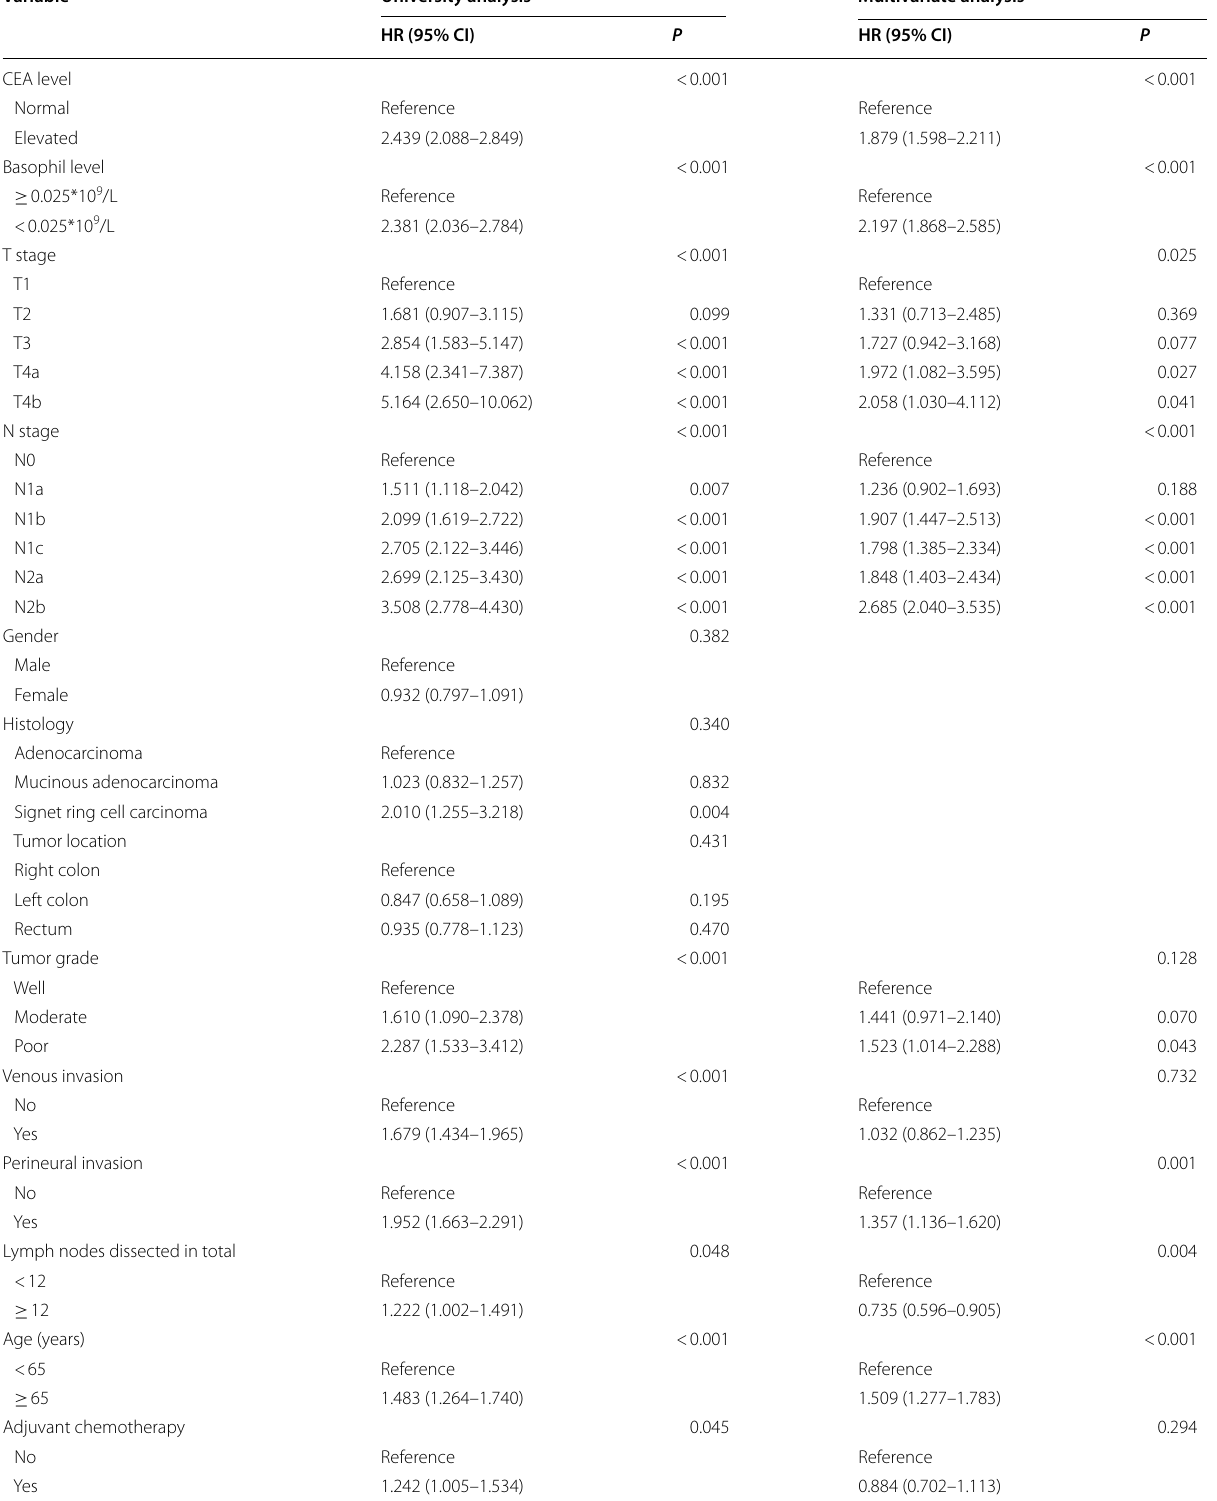
Table 1 Univariate and multivariate Cox analyses of DFS in the whole cohort